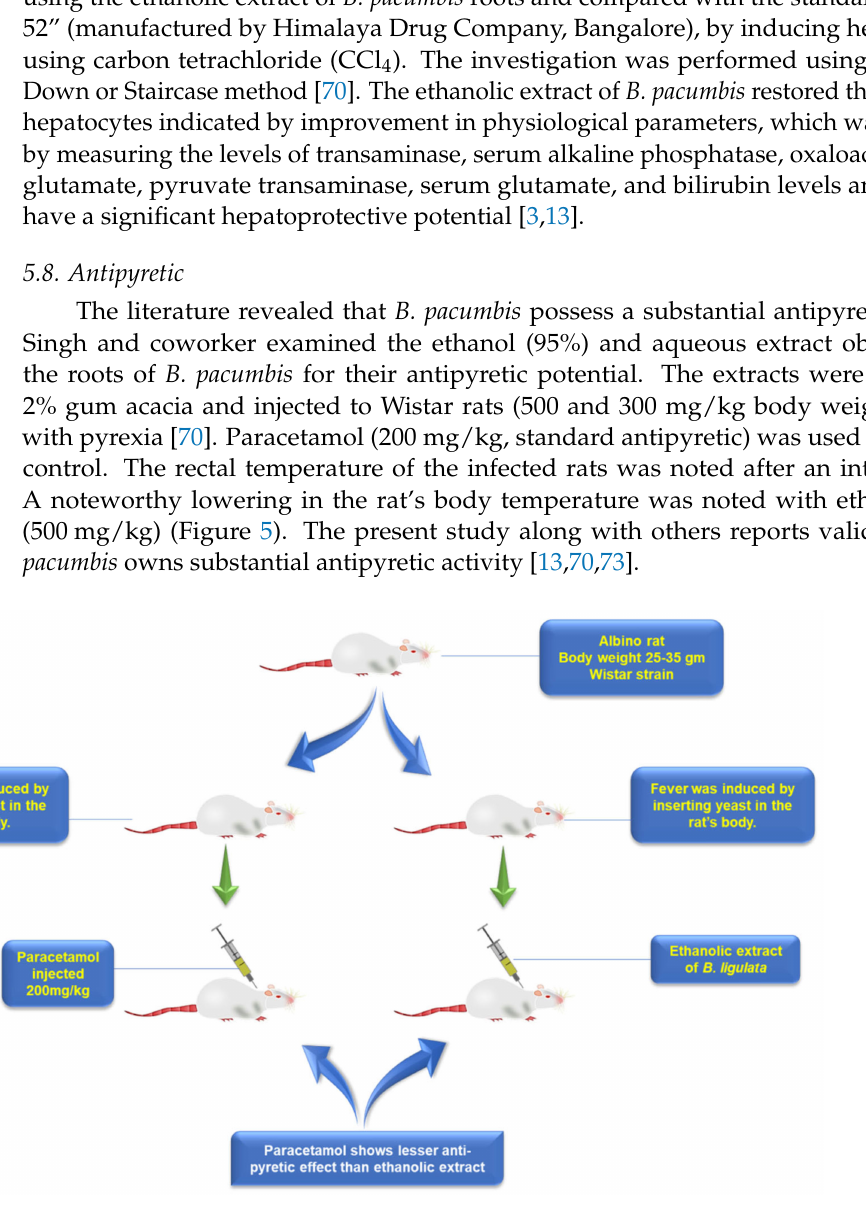
Figure 5. Antipyretic activity of Bergenia pacumbis (Buch.-Ham. ex D.Don) C.Y.Wu &